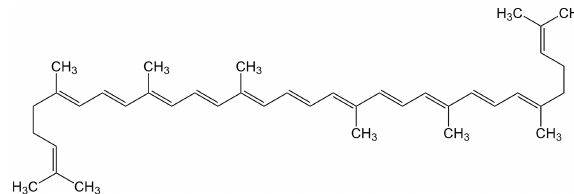
Figure 2. Molecular structure of